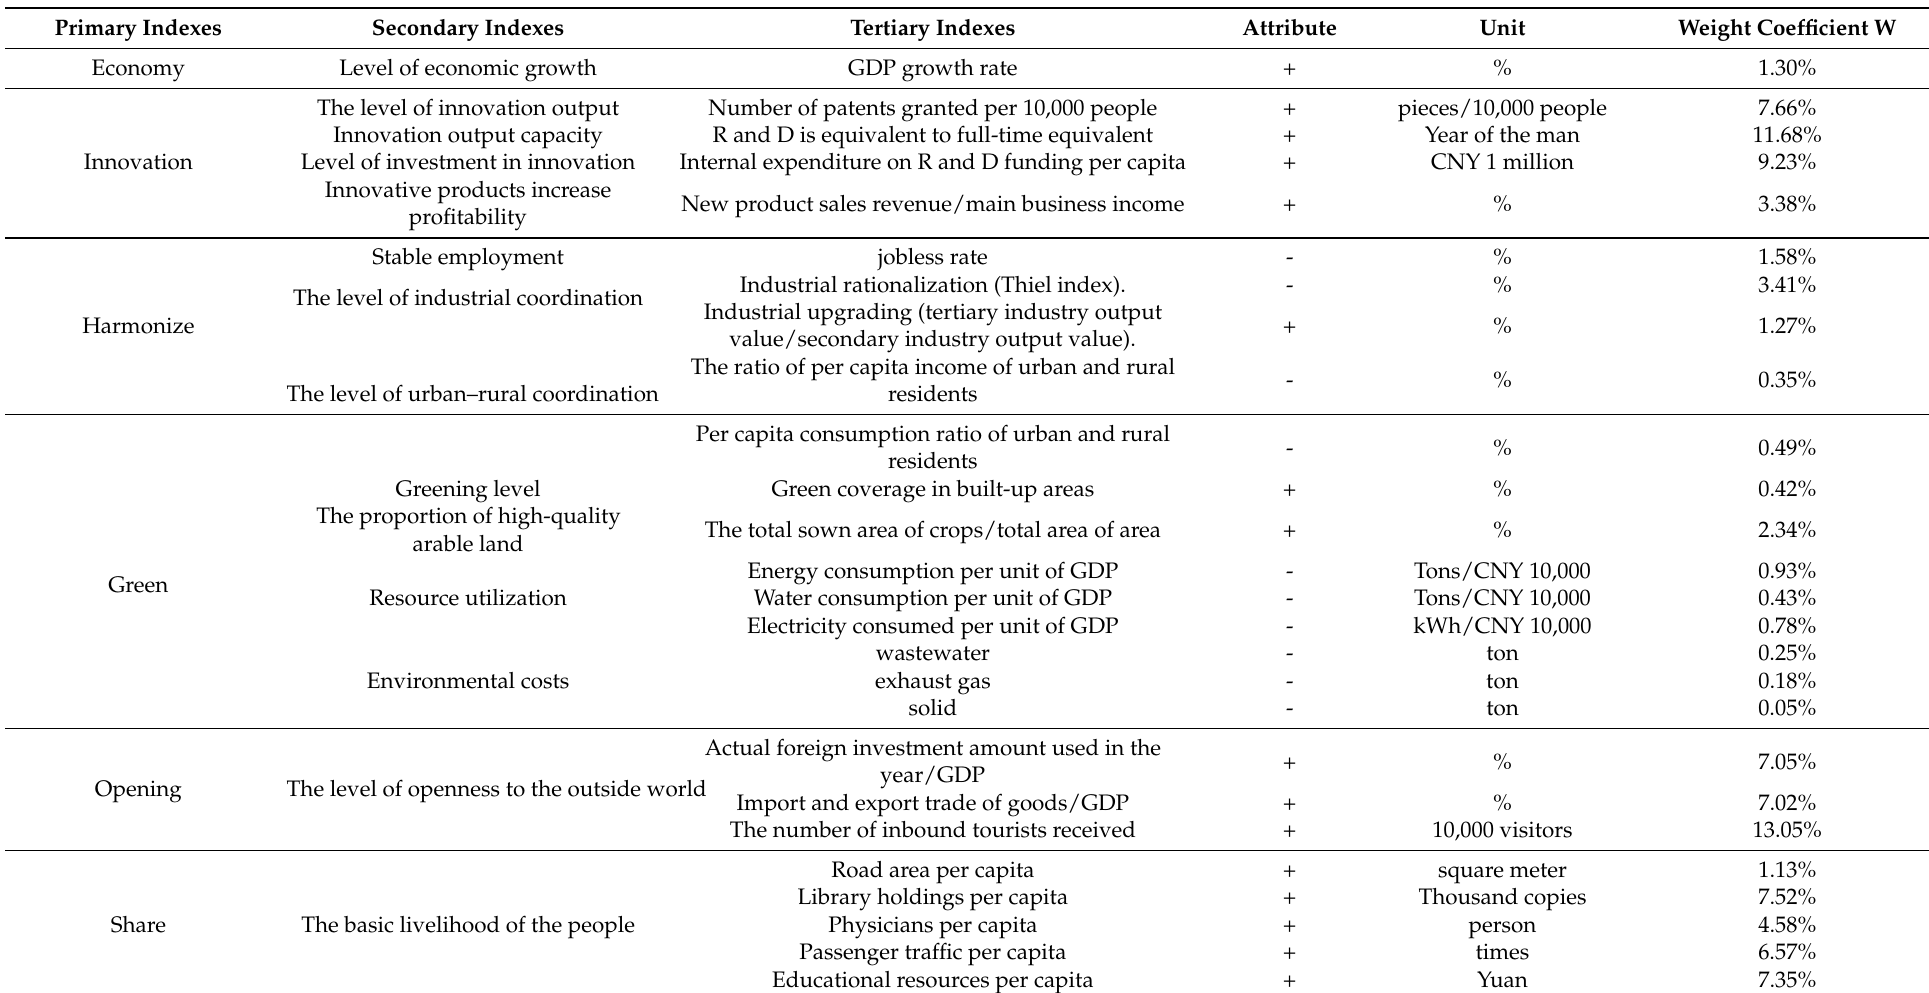
Table 1. Calculation results of entropy